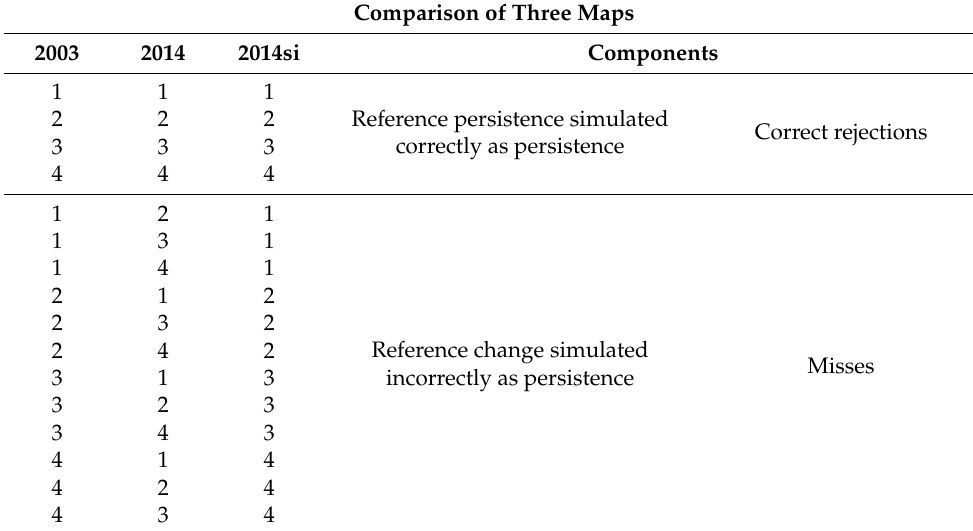
Table 3. Approach to error budgeting and correct predictions. 1 = Old-growth forest; 2 = Secondary forest; 3 = Non-Forest; 4 =